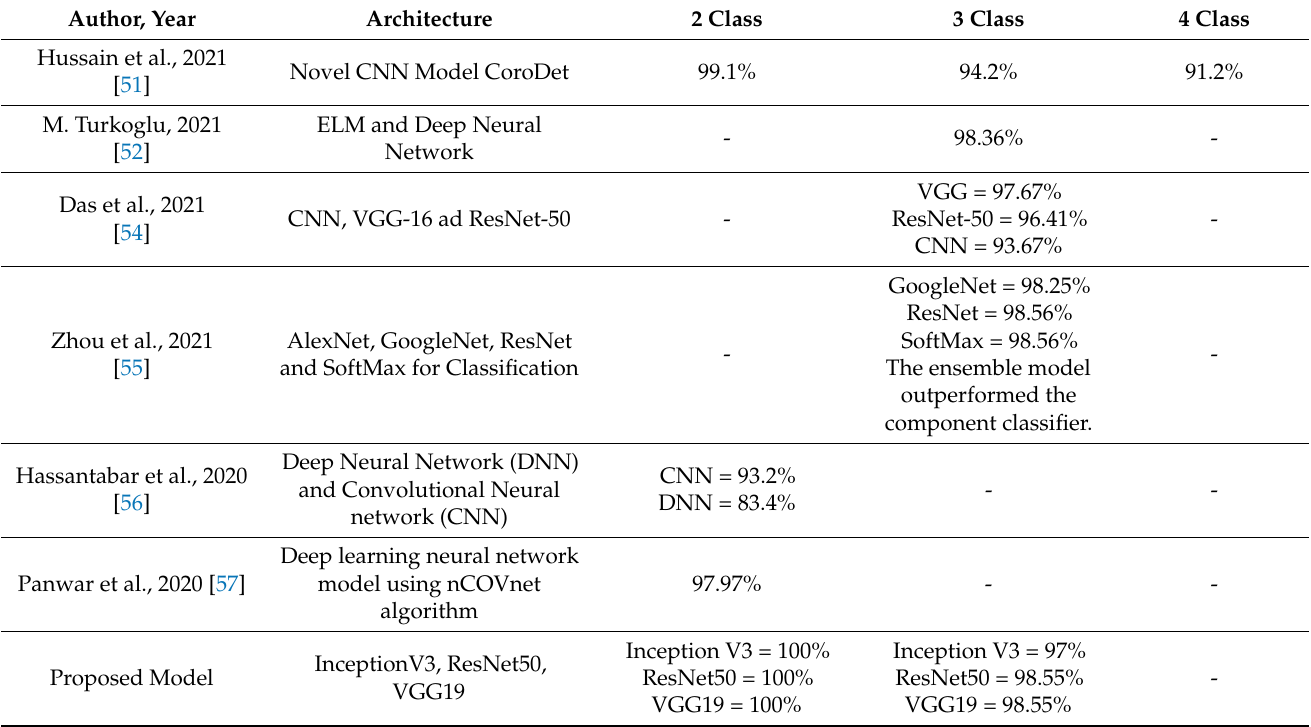
Table 4. Comparing the state of the artworks with our proposed model.